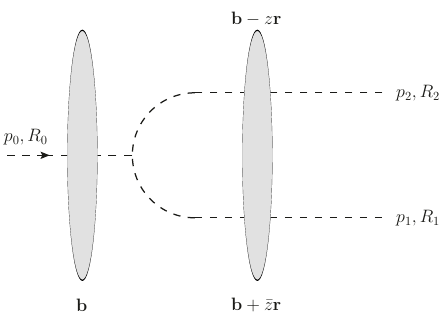
Figure 1 . Generic (0 12) process in the CGC. The partonic lines with a gray blob represent the → effective partonic lines in the external shockwave field [9, 14], as given in appendix